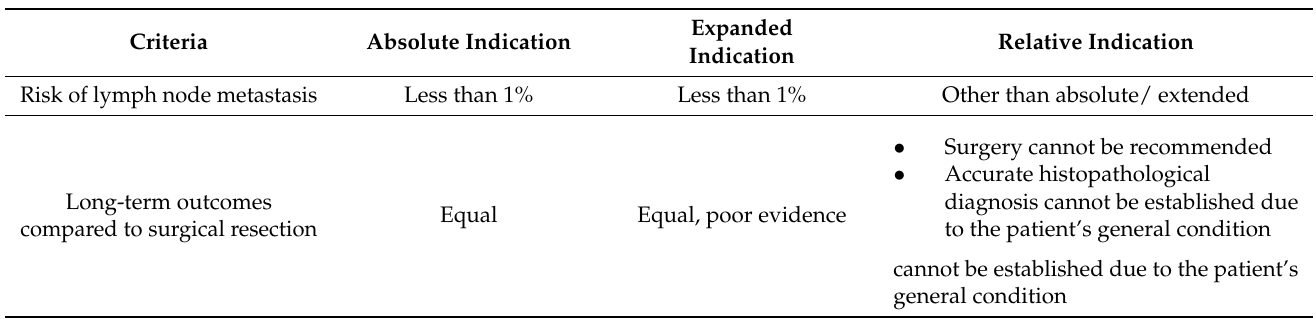
Table 4. Absolute, expanded and relative indications for endoscopic resection of EGC